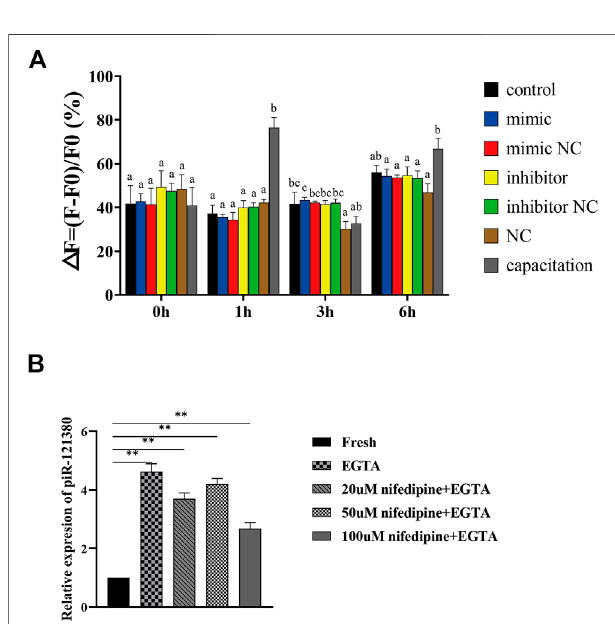
FIGURE 5 | Effect of piR-121380 on [Ca 2+ ] i of boar sperm at 37 ° C. (A) After transfection and incubation with heparin, sperm were stained with 4 μ M Fluo 4, am.The [Ca 2+ ] i wasdetermined bythefollowingequation: Δ F/F0 (%)= (F − F0)/F0 × 100%. F indicates the fl uorescent intensity of each group, and F0 indicates the fl uorescence intensity of sperm suspension without treatment. (B) Theexpression ofpiR-121380after adding 5 μ M EGTA,20 μ M nifedipine and 50 μ M EGTA, 50 μ M nifedipine and 50 μ M EGTA, and 100 μ M nifedipine and 50 μ M EGTA, respectively, into sperm to inhibit the in fl ux of Ca 2+ . The data are representative of at least three independent experiments (mean ±